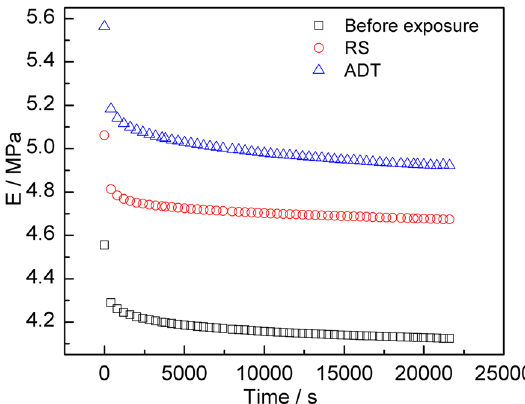
Table 1: Atomic concentration and ratios of atomic concentrations